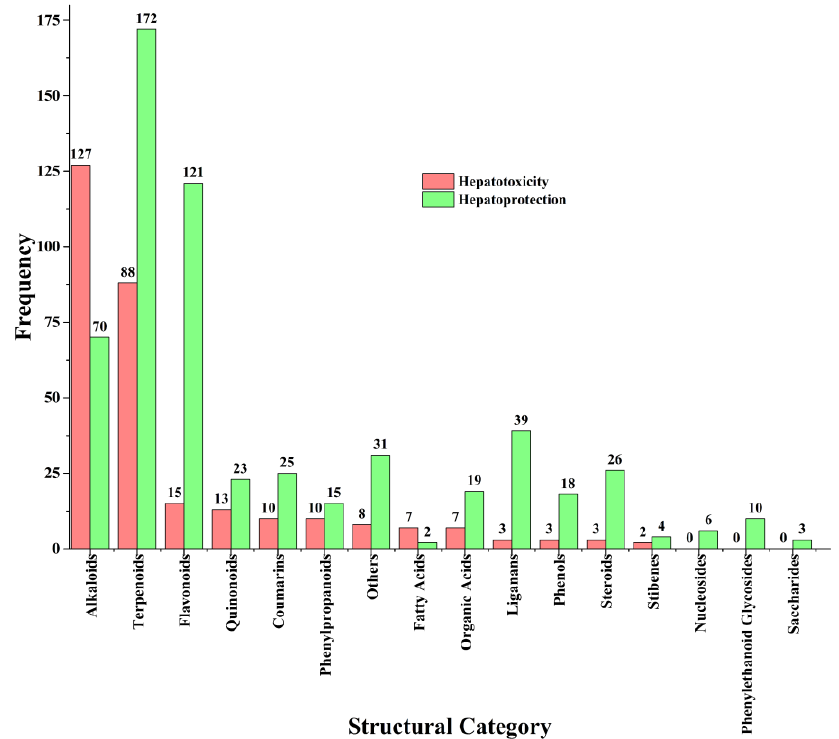
Figure 1. The structural distribution of ingredients with potential hepatotoxicity or hepatoprotection.